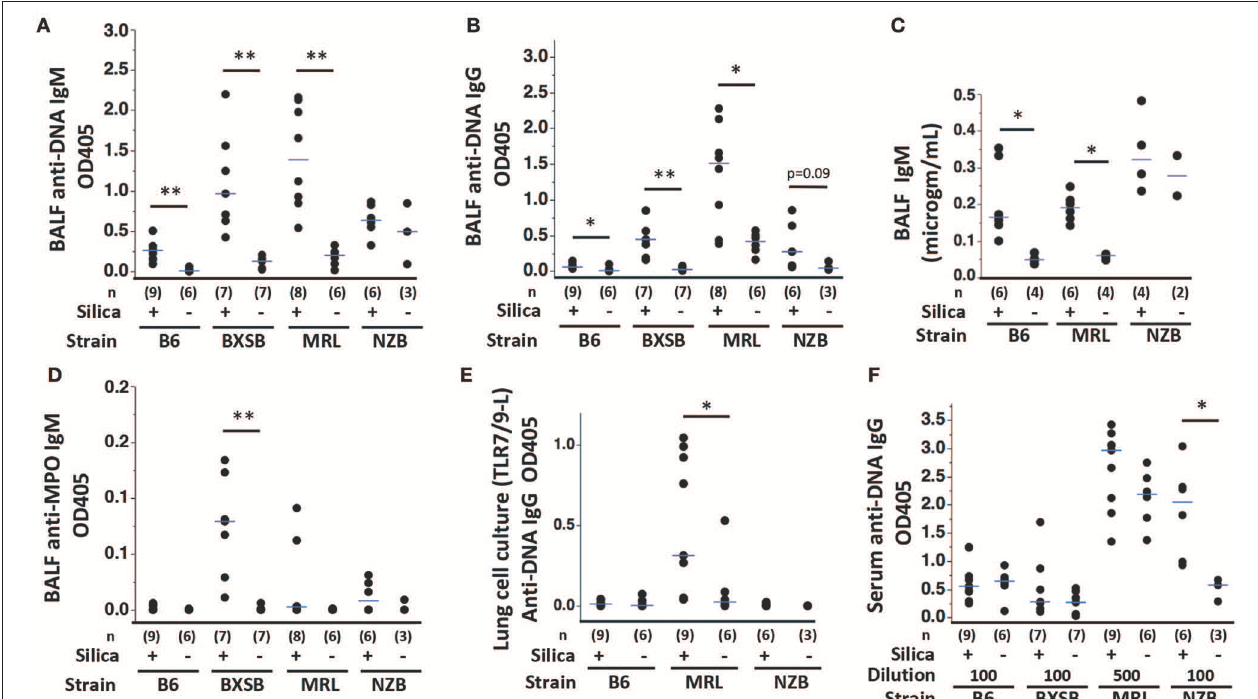
FIGURE 3 | Autoantibody production in wildtype mice of diverse genetic backgrounds exposed to silica. (A) Anti-ssDNA IgM; (B) Anti-ssDNA IgG; (C) IgM concentration; and (D) Anti-MPO IgM levels in bronchoalveolar lavage fluid (BALF) from wildtype mice 1–3 months after exposure to silica or vehicle. Autoantibody levels were measured as OD405 for binding to antigen minus binding to diluent-only using undiluted BALF in duplicate. (E) Anti-ssDNA IgG levels in supernatants derived from lung cells cultured with a mixture of TLR7 and TLR9 ligands R848 and CpG oligos, from mice of indicated exposure and strain. (F) Anti-ssDNA IgG levels in serum diluted 1/100 or 1/500, as indicated. Each symbol represents an individual mouse; the median for each group is indicated by the bar; * p < 0.05 and ** p < 0.01 for silica- vs. vehicle-exposed mice of same strain, Wilcoxon rank sum test.